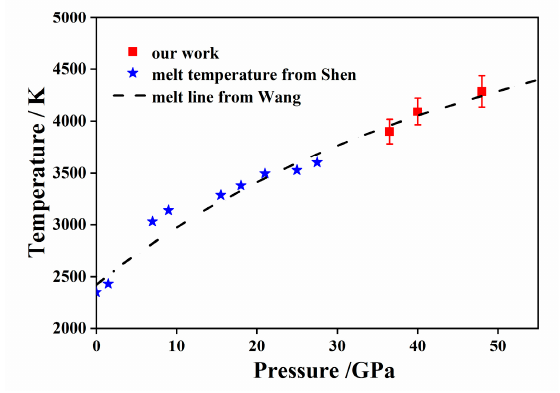
Figure 7. Comparison between radiation temperature and high pressure melt line.